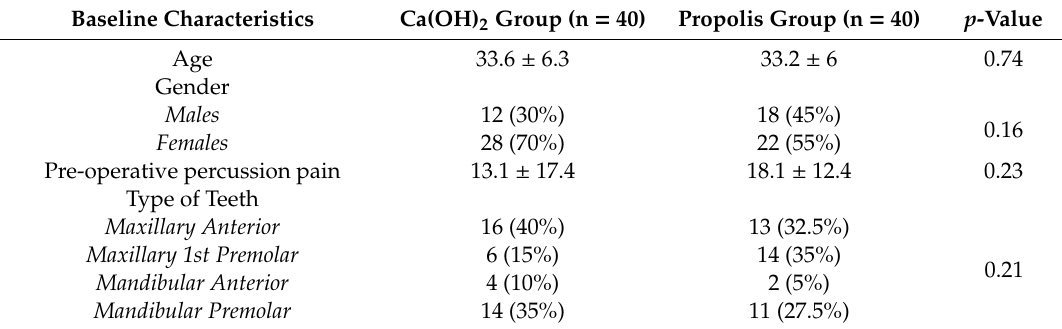
Table 1. Study sample